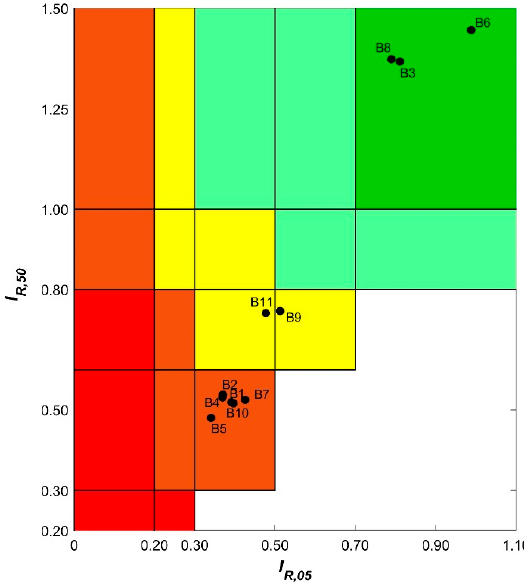
Figure 14. Seismic performance classification of the investigated buildings.